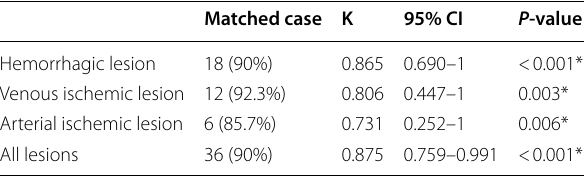
Table 5 Inter-observer agreement of the SWI regarding hemorrhagic lesion, venous ischemic lesion, arterial ischemic lesion, and all